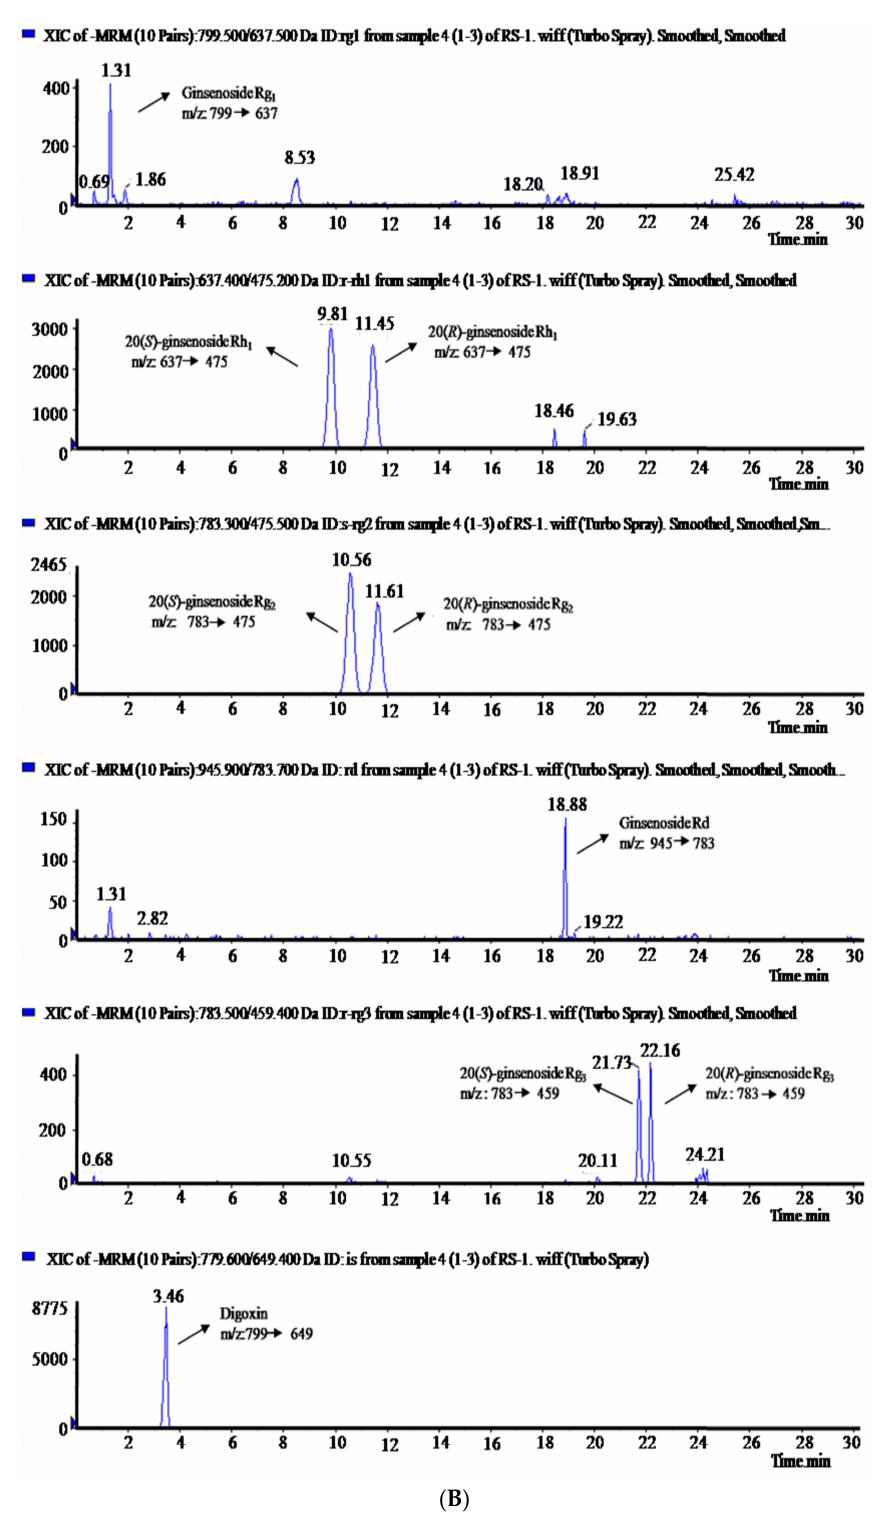
Figure 2. The extracted ionic currents: ( A ) blank plasma spiked with the eight ginsenoside standards and I.S. (digoxin); and ( B ) the plasma sample at 1 h after oral administration of 400 mg/kg GTSSL to rats spiked with I.S.